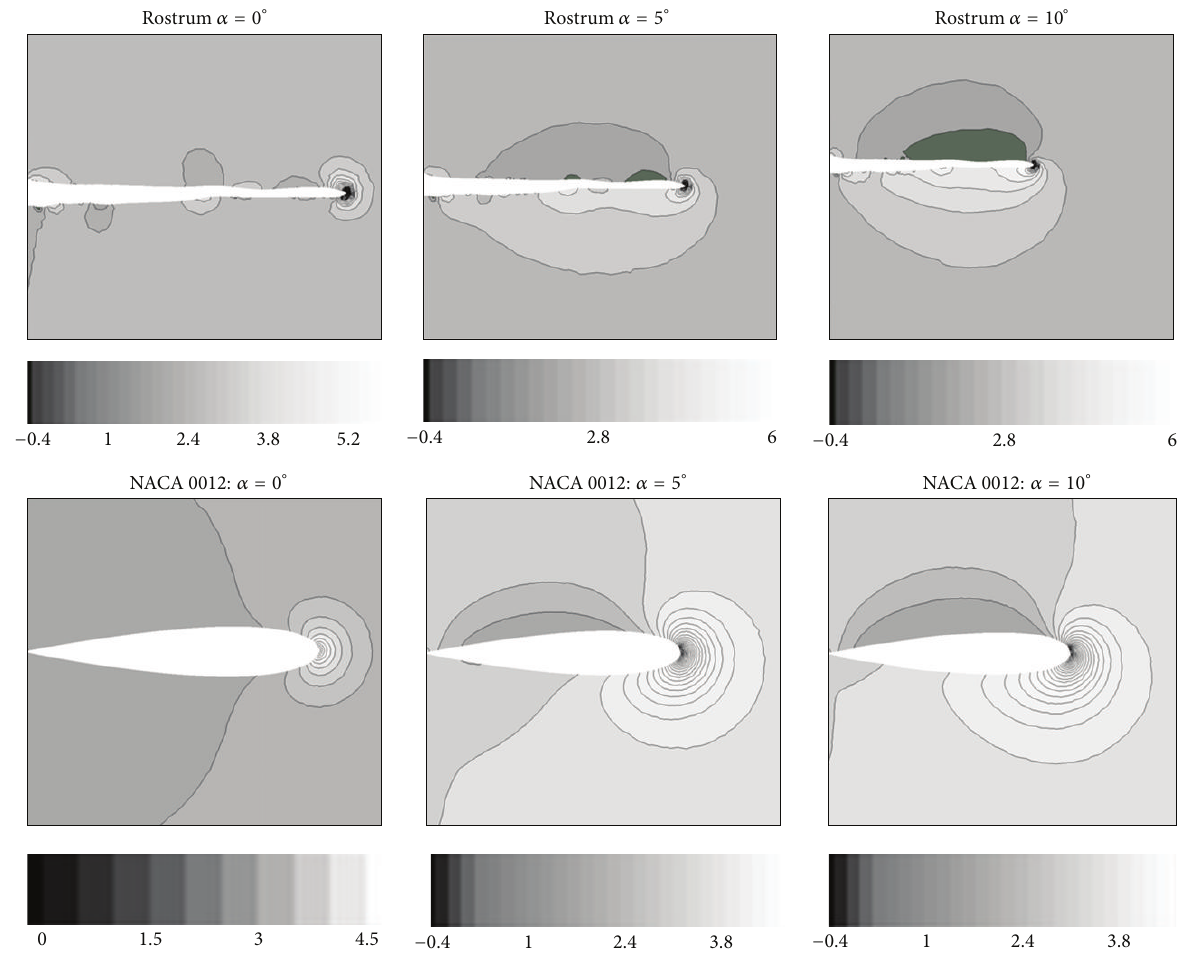
Figure 6: Pressure coefficient contour plots corresponding to 𝛼 = 0 ∘ , 𝛼 = 5 ∘ , and 𝛼 = 10 ∘ corresponding to the paddlefish rostrum and the NACA 0012 foil.